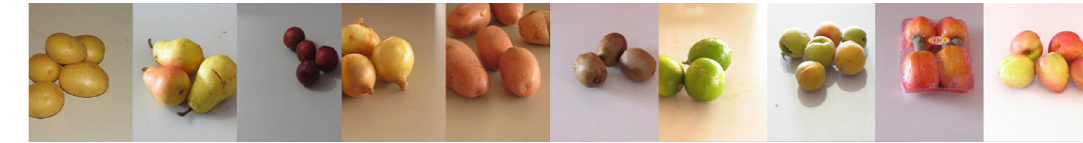
Fig. 11 FTVL dataset images